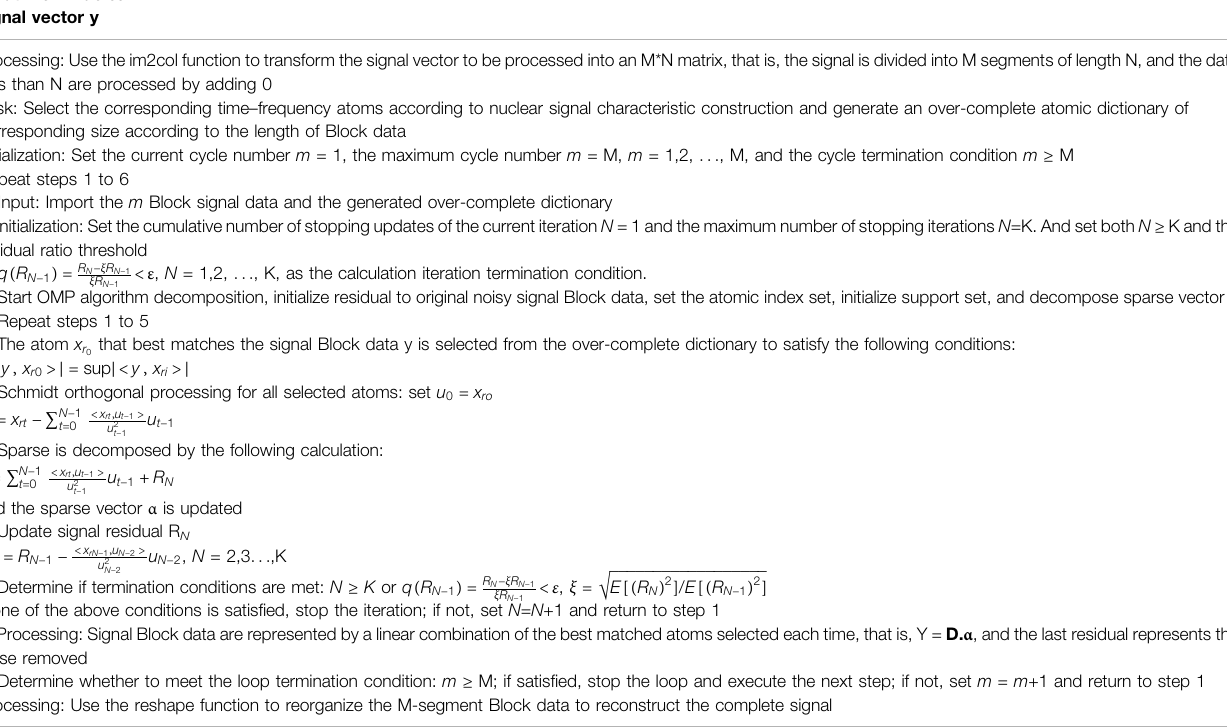
TABLE 1 | Nuclear signal sparse decomposition algorithm based on block processing. Input: Raw nuclear signal vector y Processing: Use the im2col function to transform the signal vector to be processed into an M*N matrix, that is, the signal is divided into M segments of length N, and the data less than N are processed by adding 0